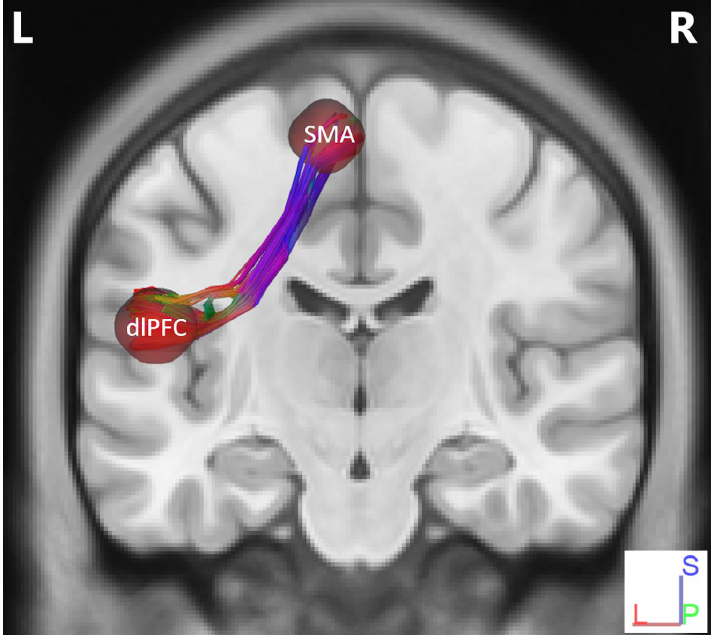
Figure 3. Fiber pathways between dlPFC and SMA for a representative participant. Here, fibers are colored-coded to represent their orientation, where “red” indicates fibers along the X -axis (i.e., left-right), “green” indicates fibers along the Y -axis (i.e., anterior-posterior), and “blue” indicates fibers along the Z -axis (i.e., inferior-superior). Brain Sci. 2021 , 11 , x